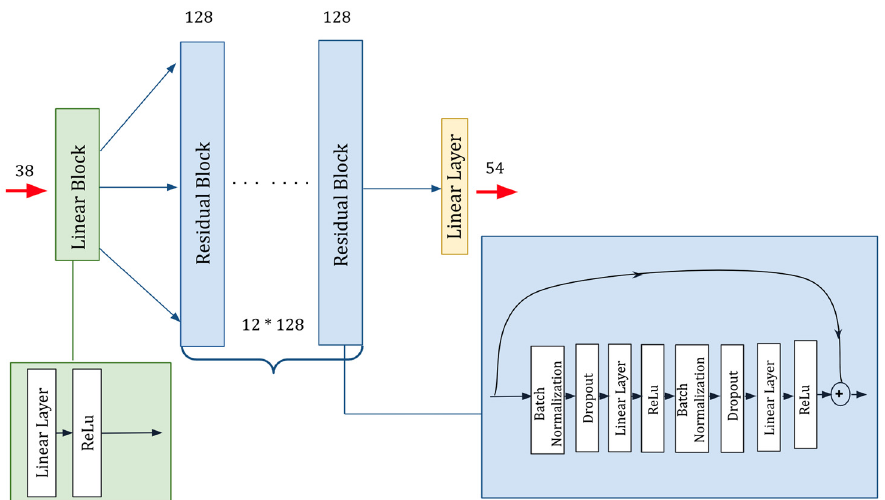
Figure 1. Schematic of the architecture of the model—dimension and structure of layers—the model